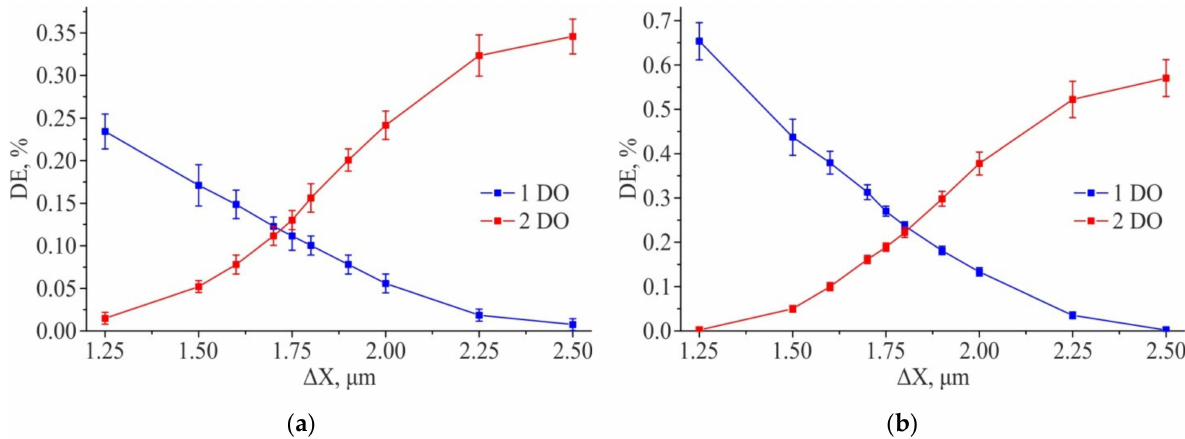
Figure 17. Measurement of diffraction efficiency of the experimental 2D DSE structures written: by CLWS300IAE ( a ); by DWL66+ ( b